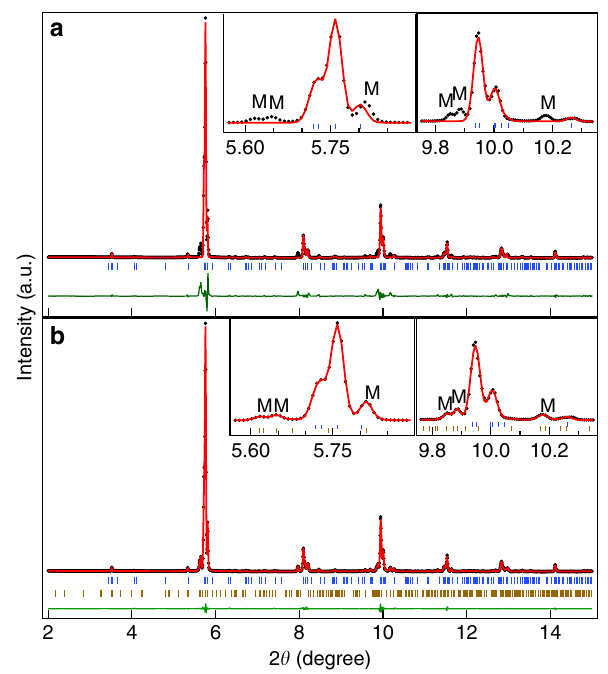
Fig. 5 Rietveld fi ts for the synchrotron X-ray powder diffraction patterns at 210 K. Rietveld re fi nements with a 3 M incommensurate premartensite structure and b Combination of 3 M premartensite and 7 M martensite structure. The experimental data, fi tted curve, and the residue are shown by circles (black), red continuous line, and green continuous line, respectively. The tick marks (blue) represent the Bragg peak positions for the premartensite phase and the lower ticks (dark yellow) in b represents the Bragg peak positions for the martensite phase. The insets show the Bragg re fl ections on an expanded